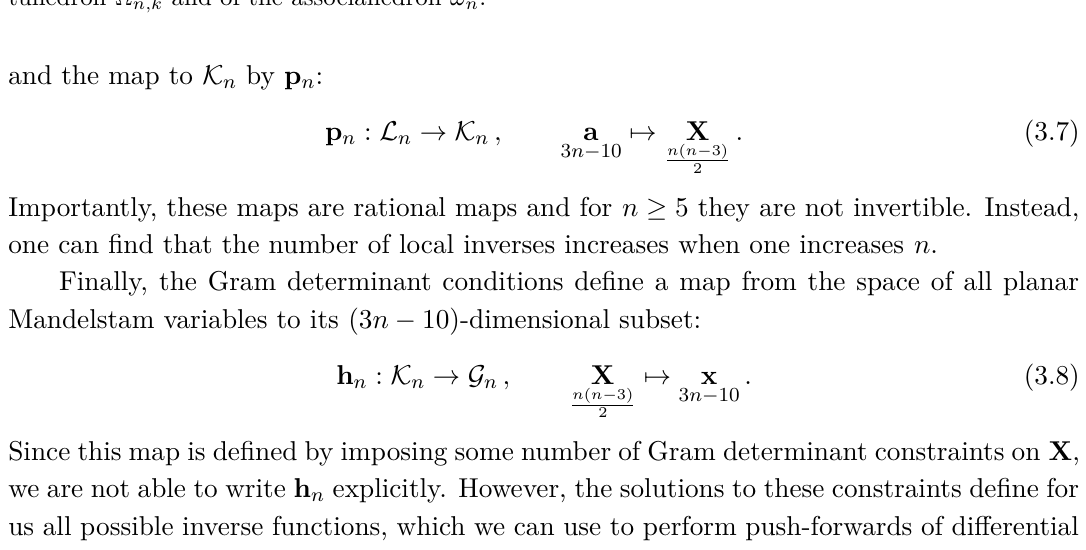
Figure 1 . Summary of the kinematic spaces and relations between them, together with the dif- ferential forms defined on these spaces. We highlight the canonical forms of the momentum ampli- tuhedron Ω n,k and of the associahedron ˜ ω n